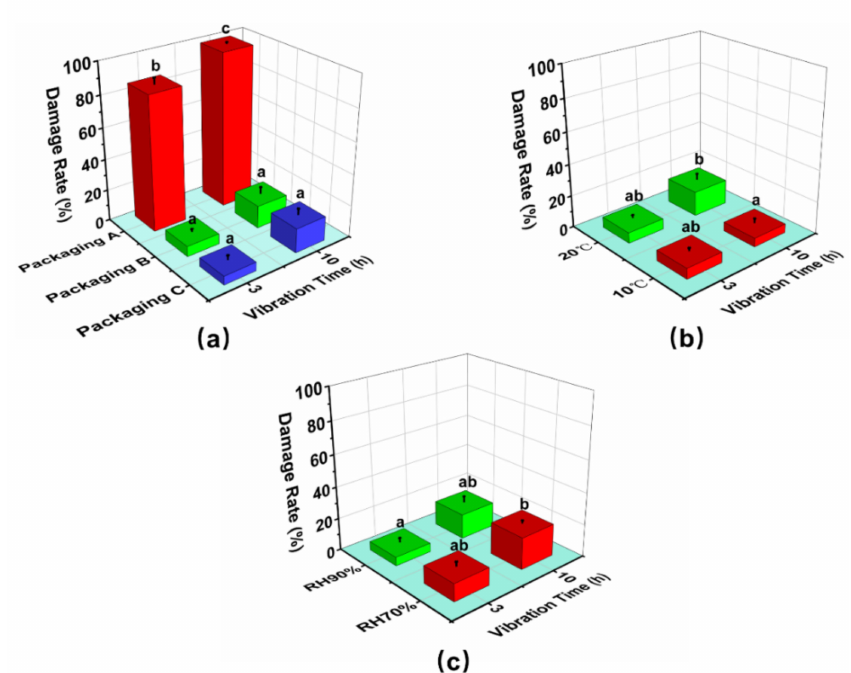
Figure 6. Damage rates after simulated transportation: ( a ) Three packaging formats vibrated at 20 ◦ C and 90% RH for 3 and 10 h. ( b ) Packaging C vibrated at 10 and 20 ◦ C and 90% RH for 3 and 10 h. ( c ) Packaging C vibrated at 20 ◦ C and 70% RH and 90% RH for 3 and 10 h. Vertical bars represent standard error. Letters on columns indicate significant differences ( p < 0.05).